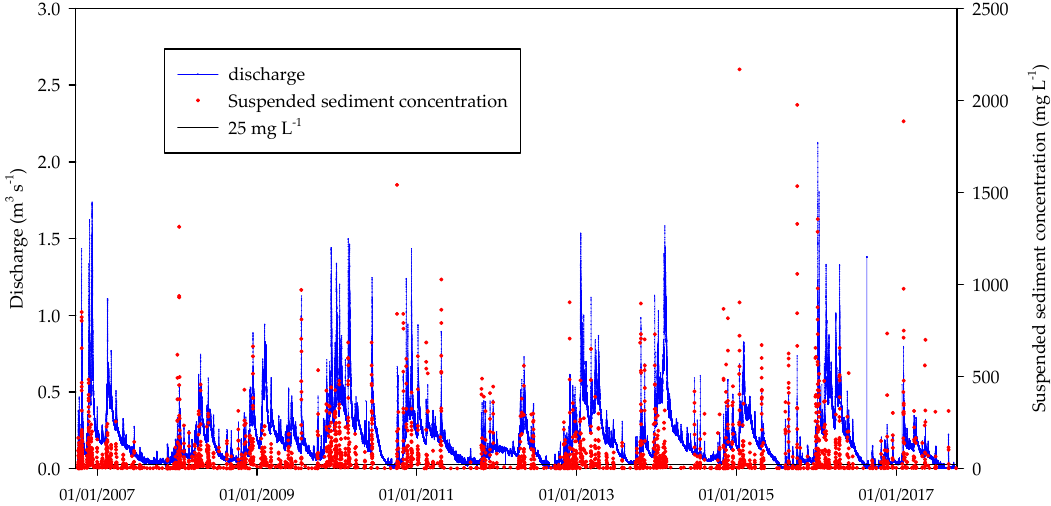
Figure 5. Discharge and suspended sediment concentrations during the study period.